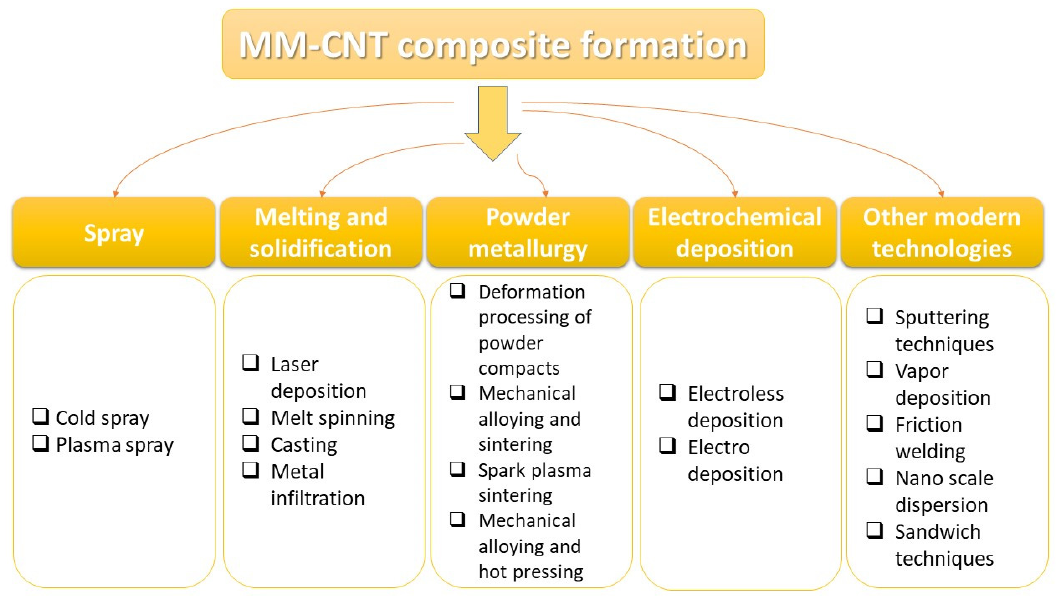
Figure 6. List of different processing routes for MM–CNT composites [5].